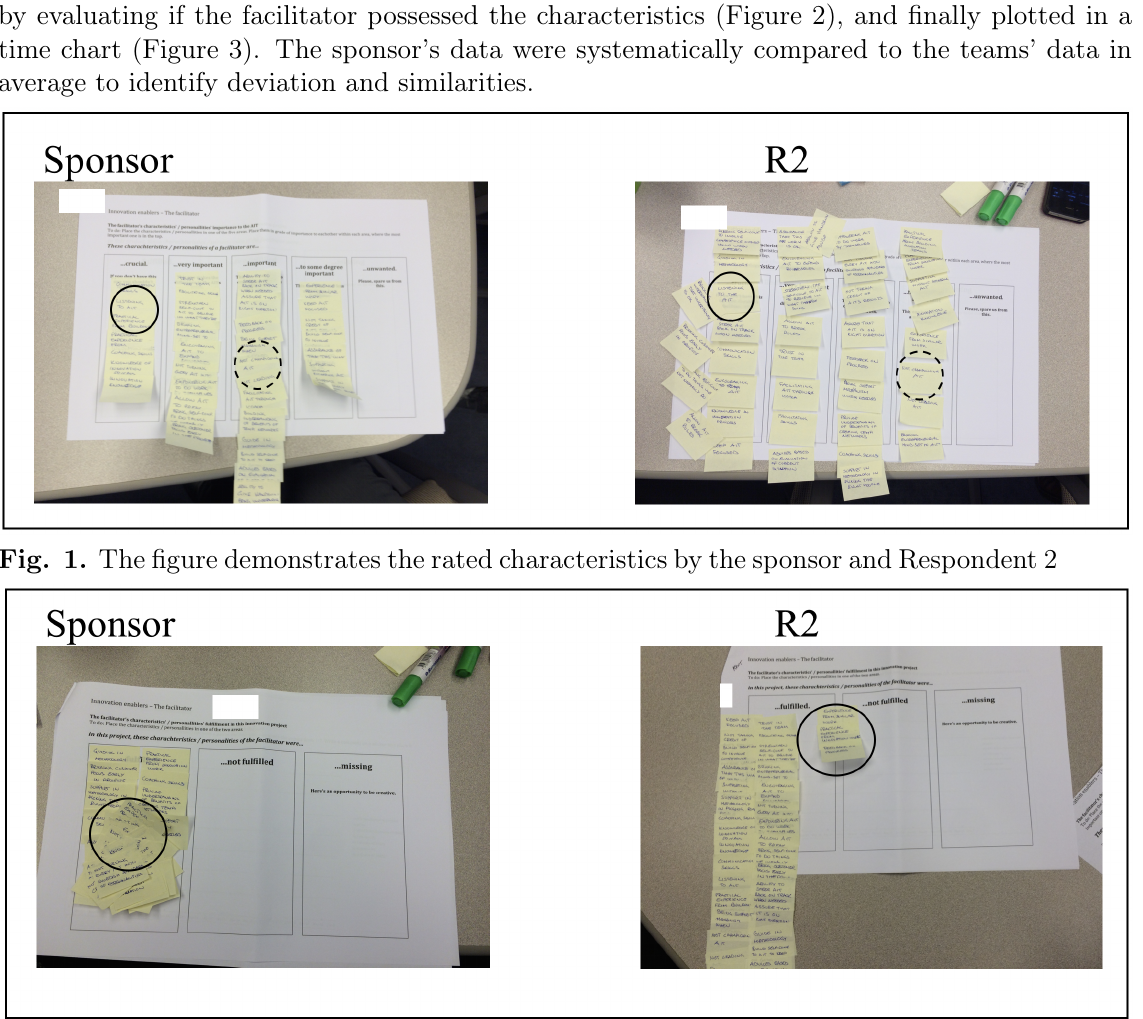
Fig. 2. The figure demonstrates how the facilitator’s characteristics correlate to the identified characteristics according to the Respondent and Respondent